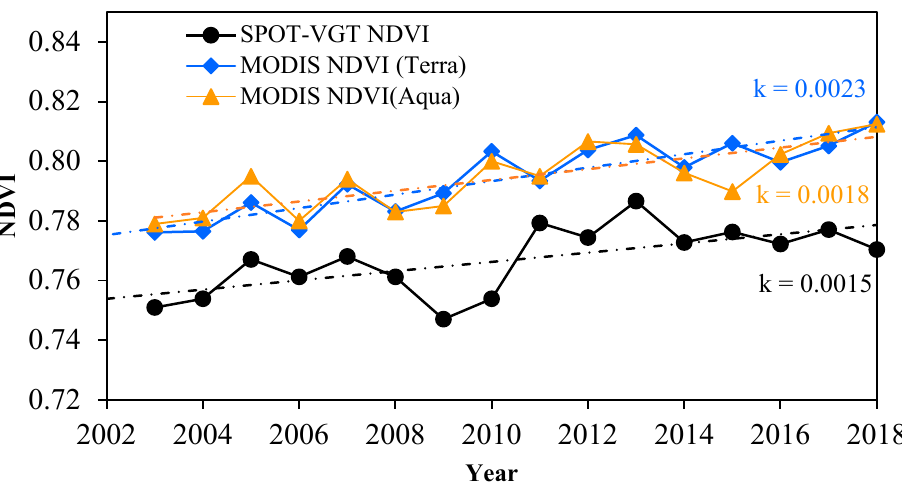
Figure 4. Comparisons between reconstructed SPOT-VGT NDVI and MODIS NDVI from Terra and Aqua collection. “k” refers to the slope of the linear fit of NDVI increasing.